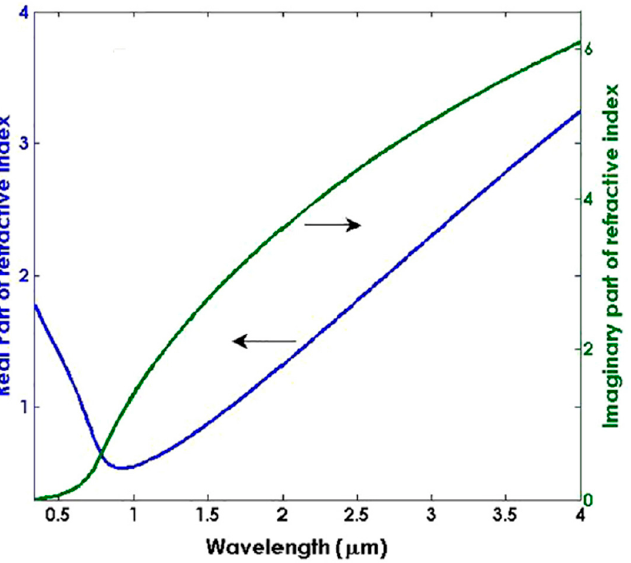
Figure 11. Dispersion curves for ZnO. Reprinted with permission from [84], copyright The Optical Society.